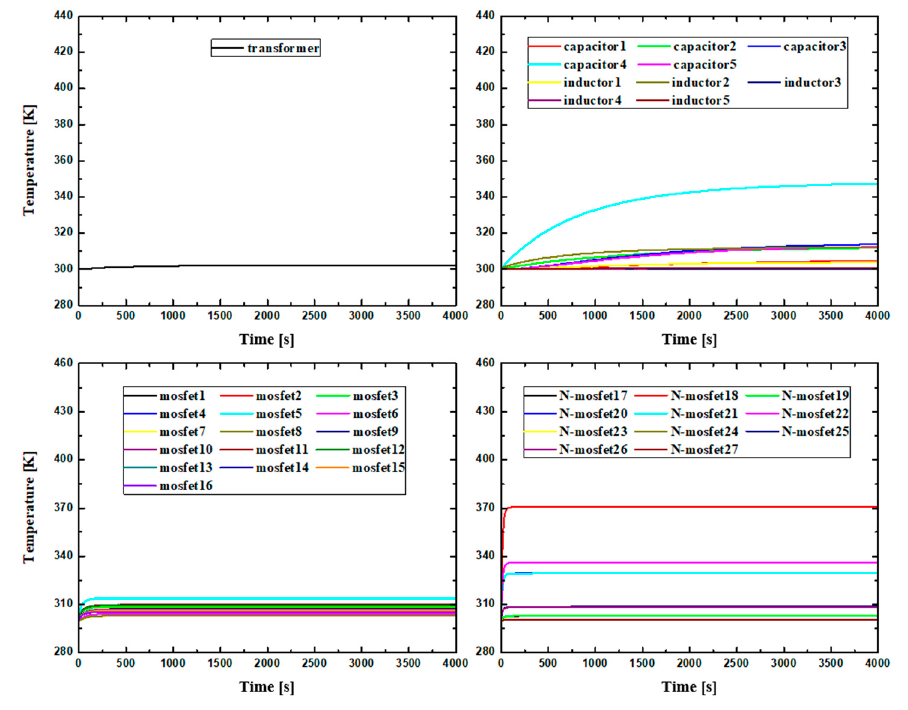
Figure 15. Temperature profile of the integrated module for a cooling water flow rate of 6 LPM in Operating Mode 4.